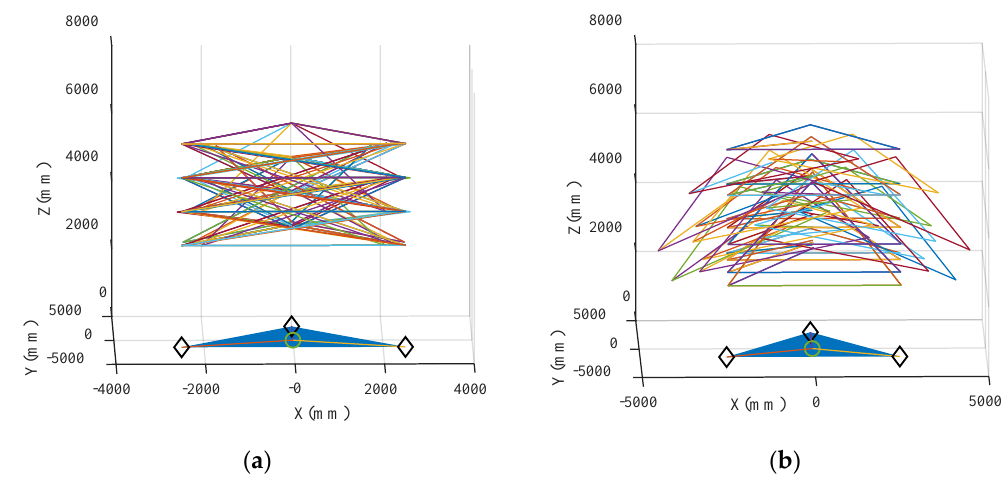
Figure 11. Moving platform motion space comparison: ( a ) is a parallel platform moving platform 3-RPS compensation movement space; ( b ) is the 3-SPR parallel compensation platform’s motion space. In both figures, the solid triangular pattern at the bottom indicates the fixed platform, while the solid triangular lines at the top forms the moving platform under different poses.